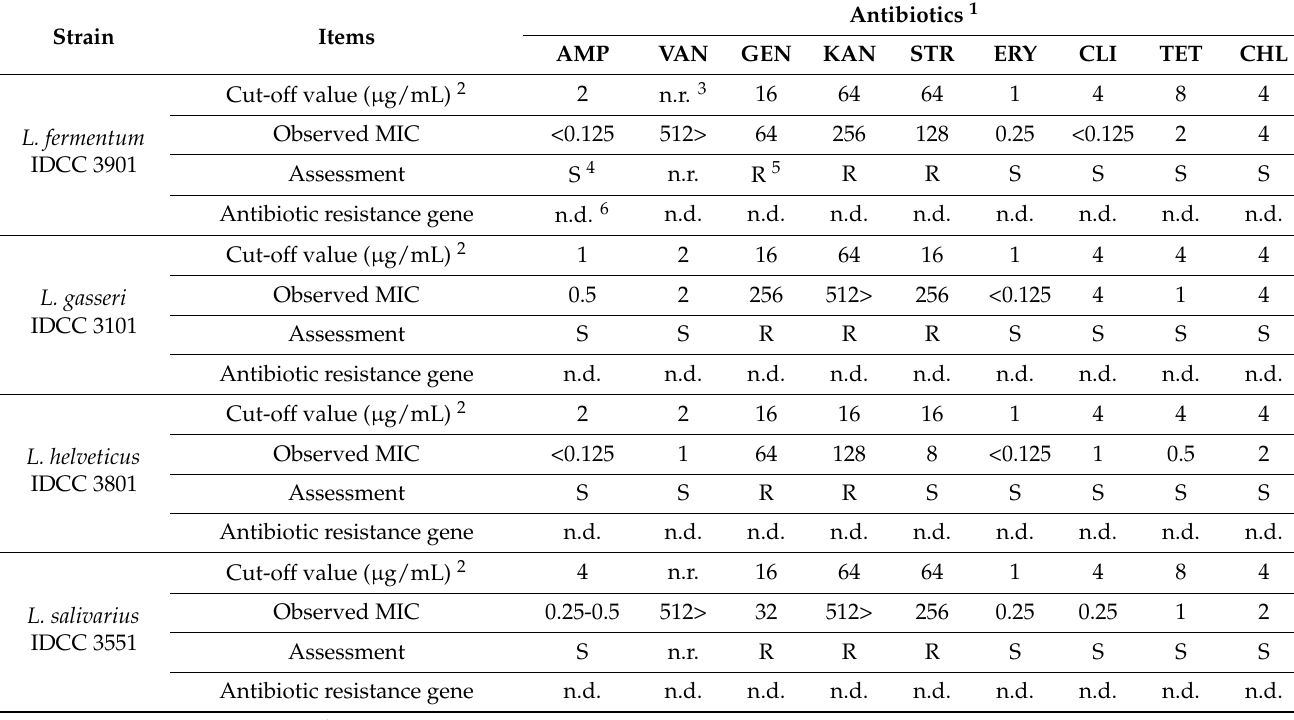
Table 4. Minimal inhibitory concentrations and antibiotic resistance genes of four Lactobacillus